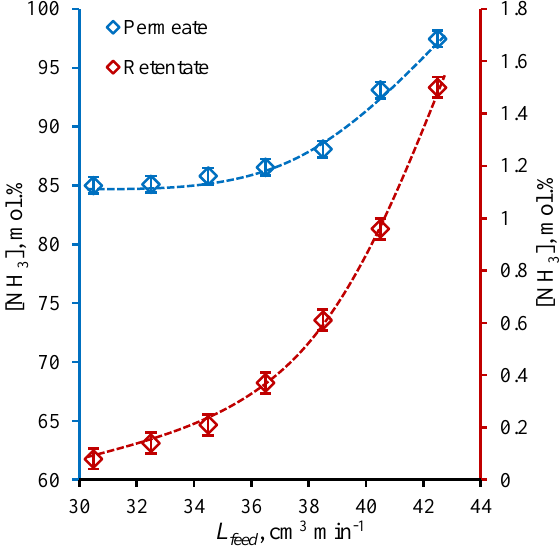
Figure 6. The NH 3 concentration (mol%) in permeate and retentate flows under H 2 /N 2 mix sweep of cell’s bore as a function of feed flow rate (cm 3 min − 1 ) during a steady-state ammonia capture process.